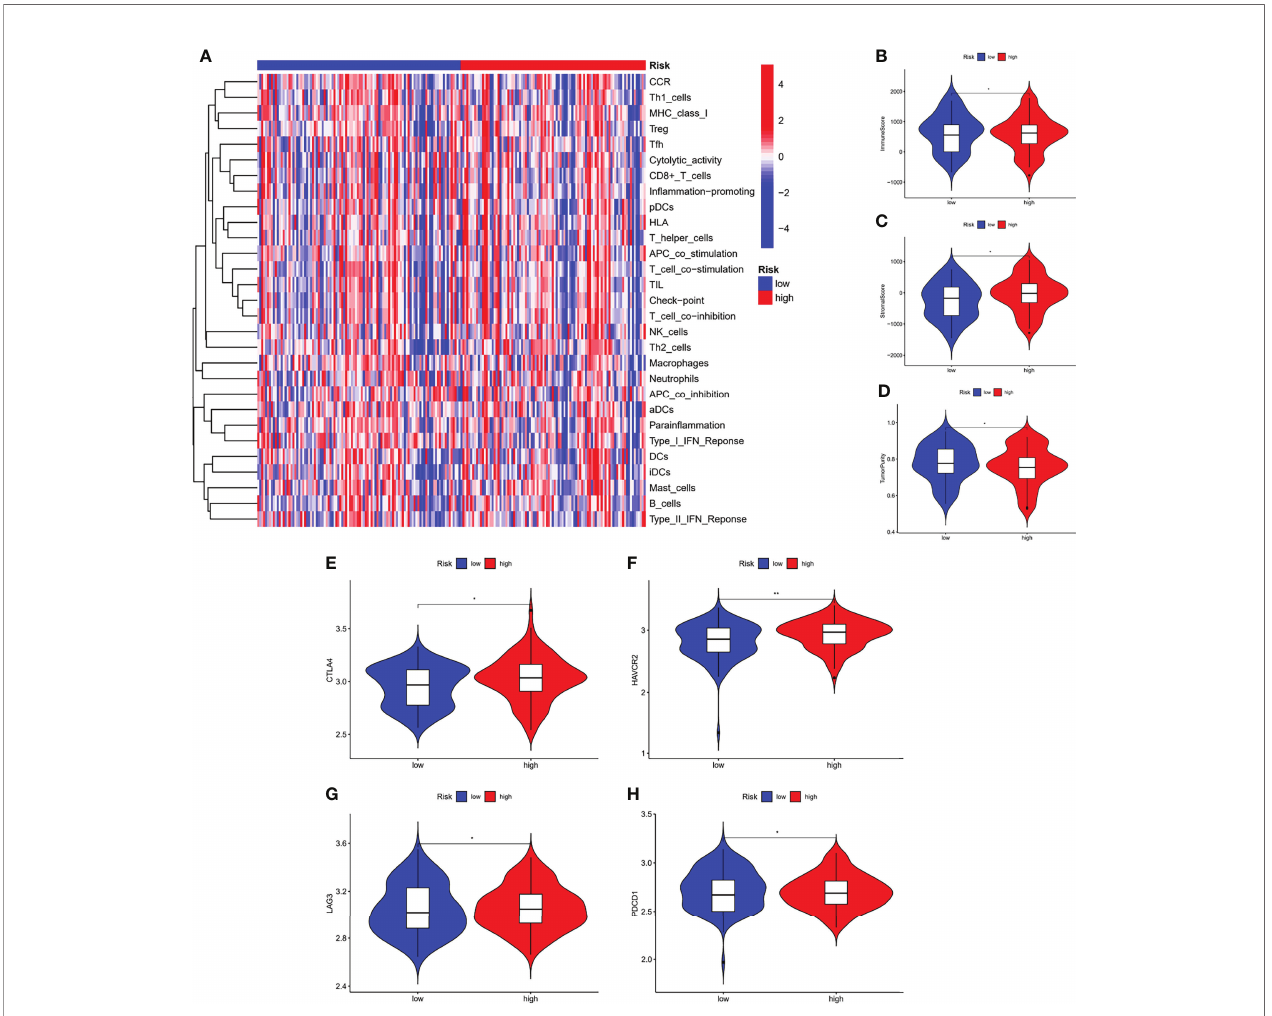
FIGURE 9 | Immunological characteristics of different risk subgroups. (A) Heat map of differences in immune cell in fi ltration between different risk subgroups. The expression levels of the immune score (B) , stromal score (C) , and tumor purity (D) , between different risk subgroups. (E – H) The expression levels of immune checkpoint genes between different risk subgroups. * P < 0.05, ** P <